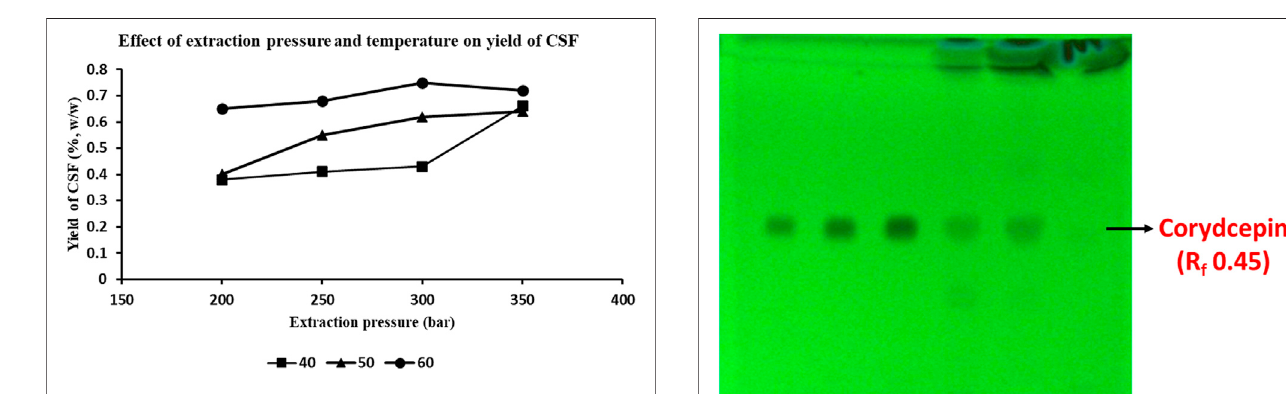
FIGURE 1 | Effect of extraction pressure and temperature on the yields of C. sinensis supercritical fl uid (CSF) extracts. Combination of various pressures (200, 250, 300 and 350 bar) and temperatures 40, 50, and 60 ° C were used for the optimization protocol. 1% (v/v) ethanol was used as entrainer. CO 2 fl ow rate was 0.4 L/h. FIGURE 2 | HPTLC chromatogram at 254 nm shows bands distinctive